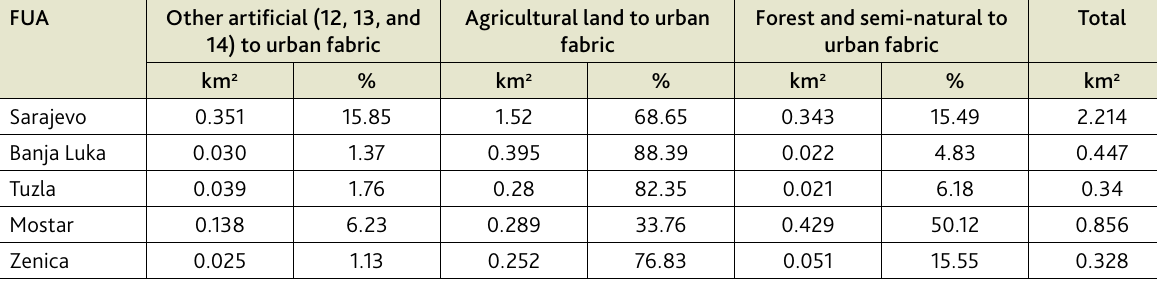
Table 7. Structure of urban fabric sprawl to other land cover types